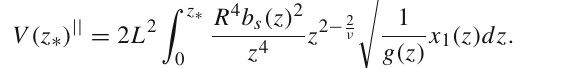
the complexity of the mixed state defined on the boundary with a subregion like a rectangular region A in our case, is dualtothevolumeenclosedbytheminimalhyper-surface γ A , appearing in the holographic entanglement entropy proposal [11],